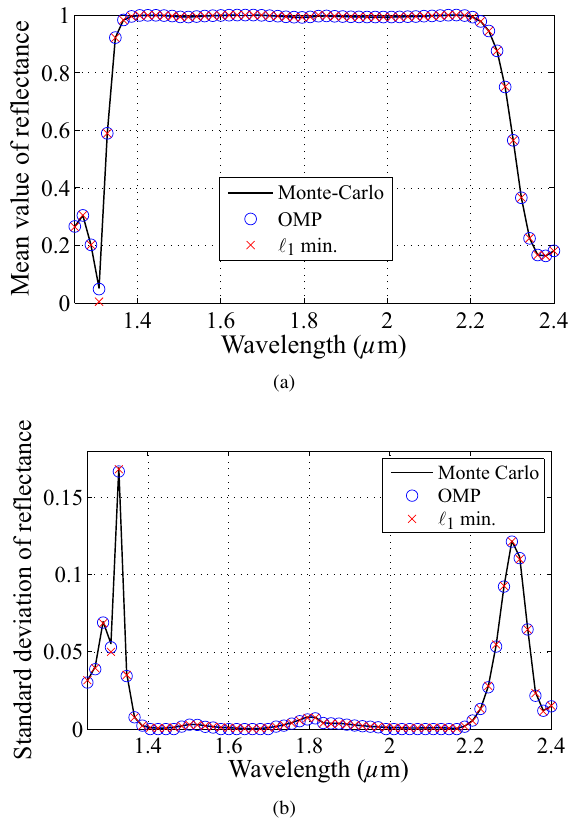
Figure 3: (a) Mean value and (b) standard deviation of the reflectance of the periodic-grating optical filter of Fig. 2 for normal incidence.